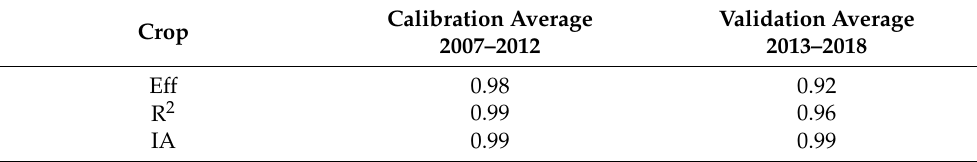
Table 9. Summary efficiency values of simulated against observed crop yields.